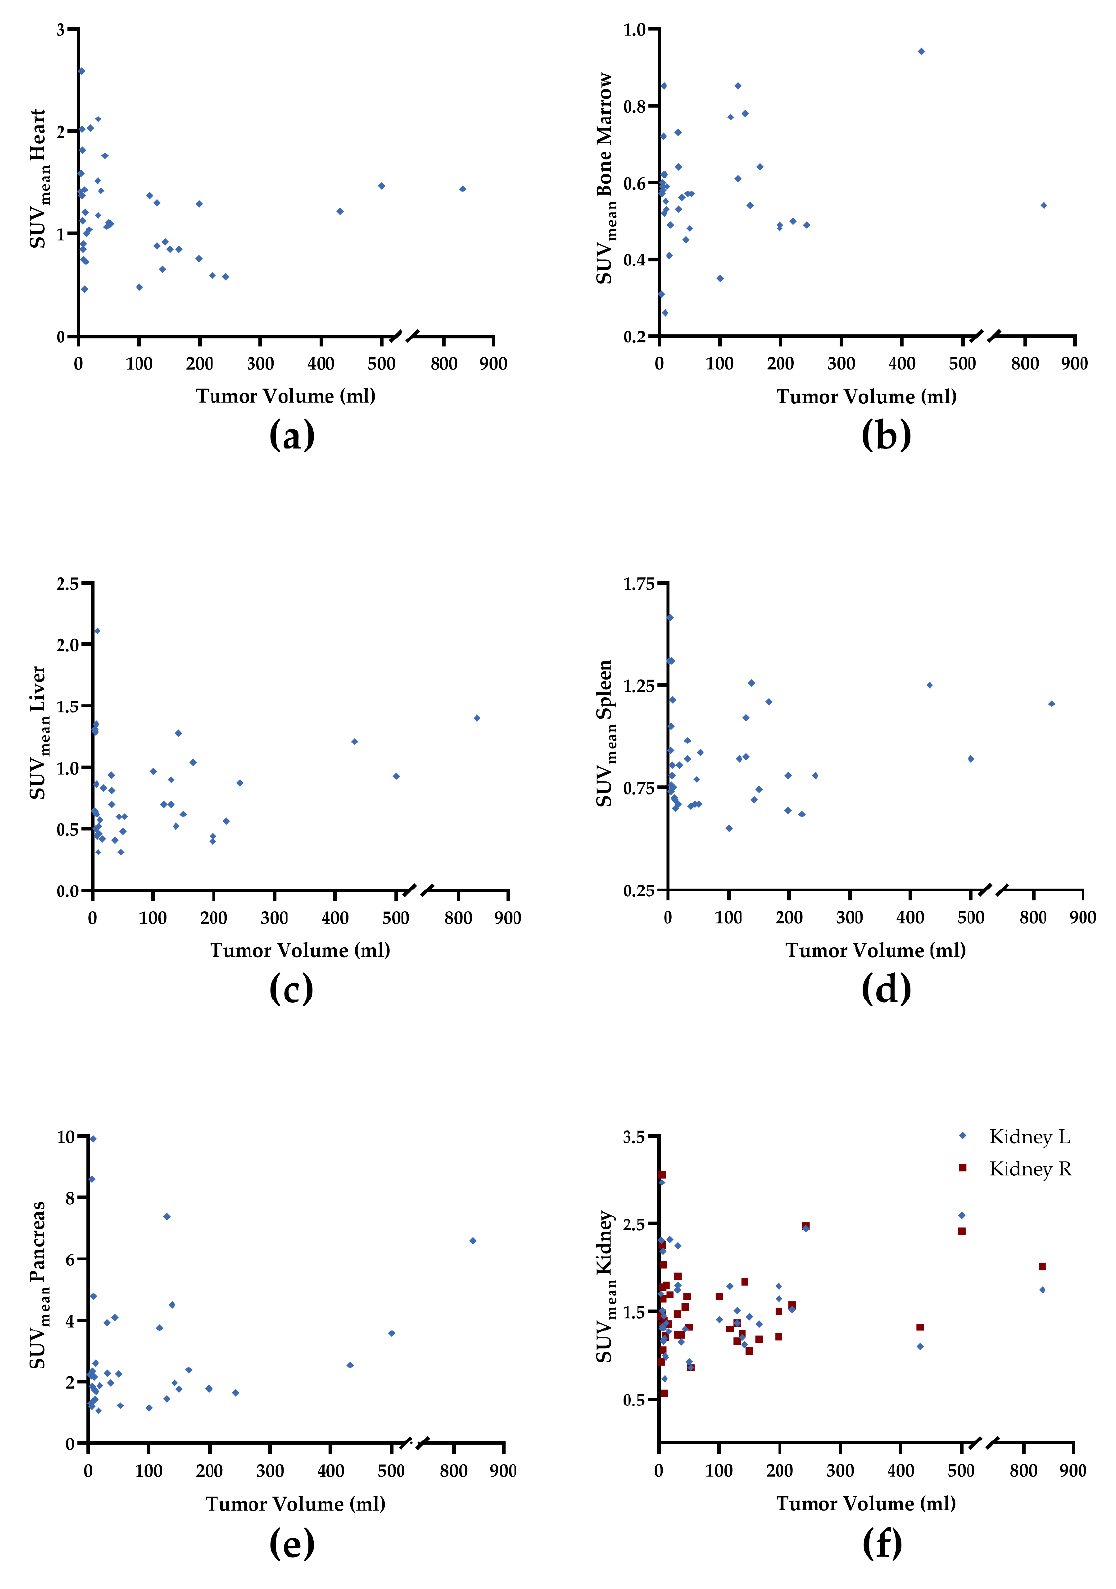
Figure 2. Correlative plots of PET-based tumor volume (cm 3 ) and mean standardized uptake values (SUV mean ) from organs: ( a ) heart; ( b ) bone marrow, ( c ) liver, ( d ) spleen, ( e ) pancreas, and ( f ) kidney. Rhombuses and squares are partially overlaid. No significance was reached. R = right. L = left.